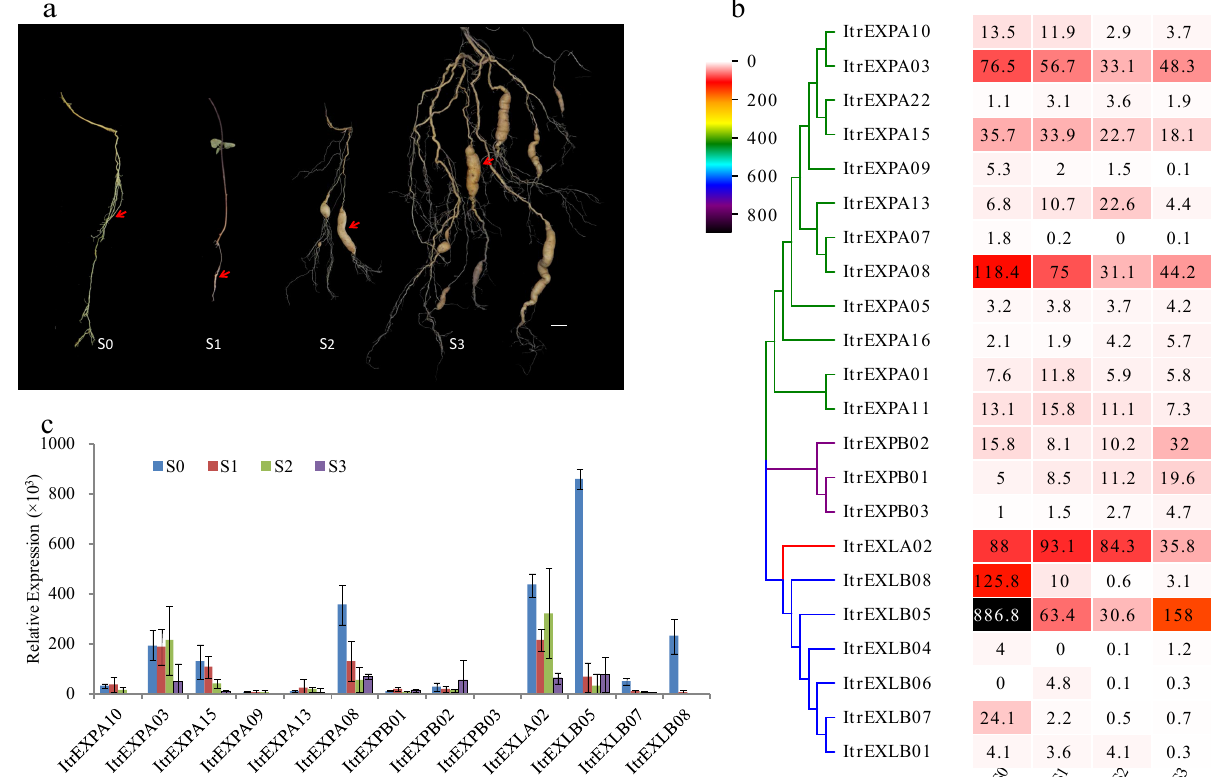
Figure 6. Expression profiling of ItrEXPs during the SR development of Y22. ( a ) Four typical stages (red arrows) of Y22 SR development. S0, AR stage; S1, ISR stage; S2, YSR stage; S3, MSR stage. Bar = 2 cm. ( b ) Expression patterns of ItrEXPs expressed during SR development. The expression value (RPKM) of expansin genes greater than 1 are showed in the heatmap. ( c ) qRT–PCR results of the randomly selected ItrEXPs